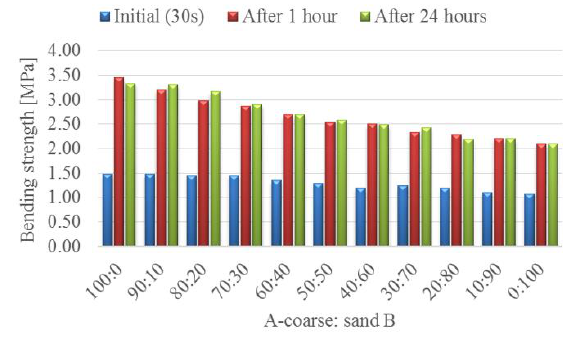
Figure 13. Strength behavior for sand combination A coarse and sand B.